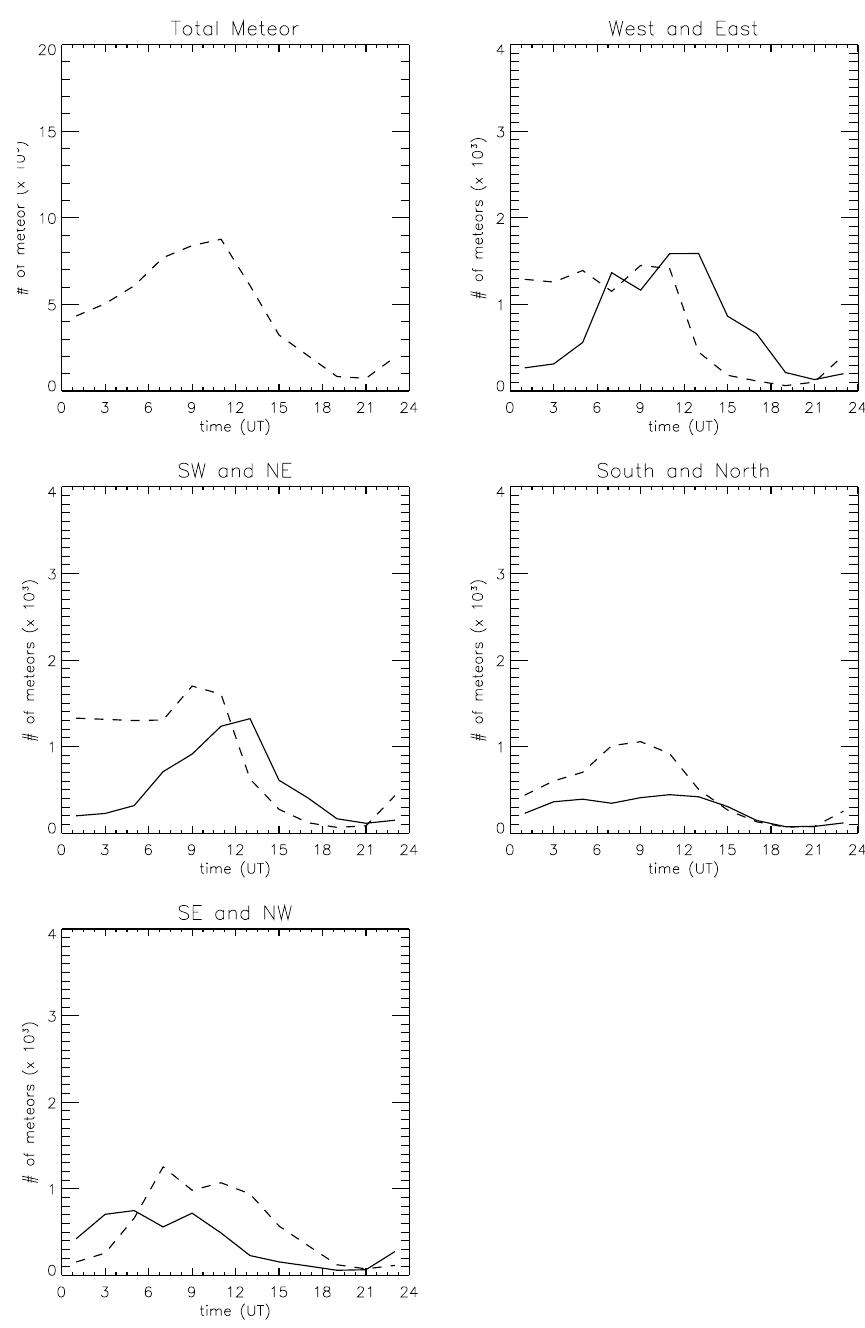
Fig. 1. Meteor distribution for Cachoeira Paulista (23 ◦ S, 45 ◦ W) during October 2005. Dashed lines indicate the first component specified above each graph. For example, the dashed line in the top right panel means west and the solid line means